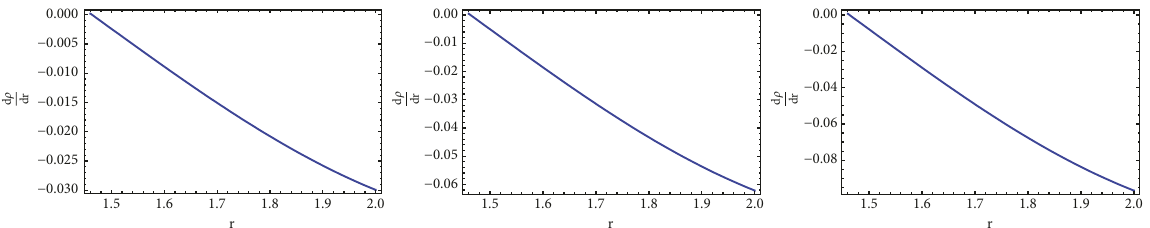
Figure 6: This figure represents the variation of 𝑑𝜌/𝑑𝑟 versus 𝑟 (km) for the strange star taking 𝛽 = 1 , 𝛽 = 2 , and 𝛽 = 3 .